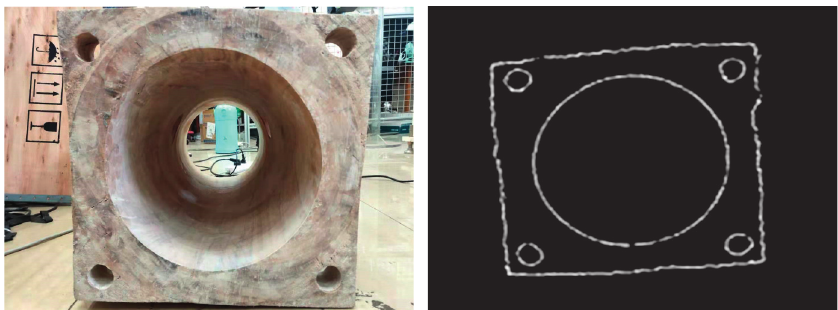
Figure 6: Special-shaped porous casting’s boundary.